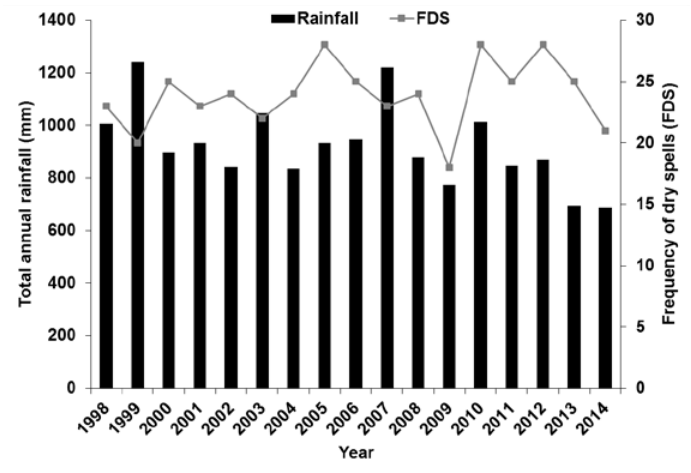
Figure 5. Total annual rainfall and frequency of dry spells (FDS) in the Vea and Bongo irrigation schemes during the years 1998–2014.